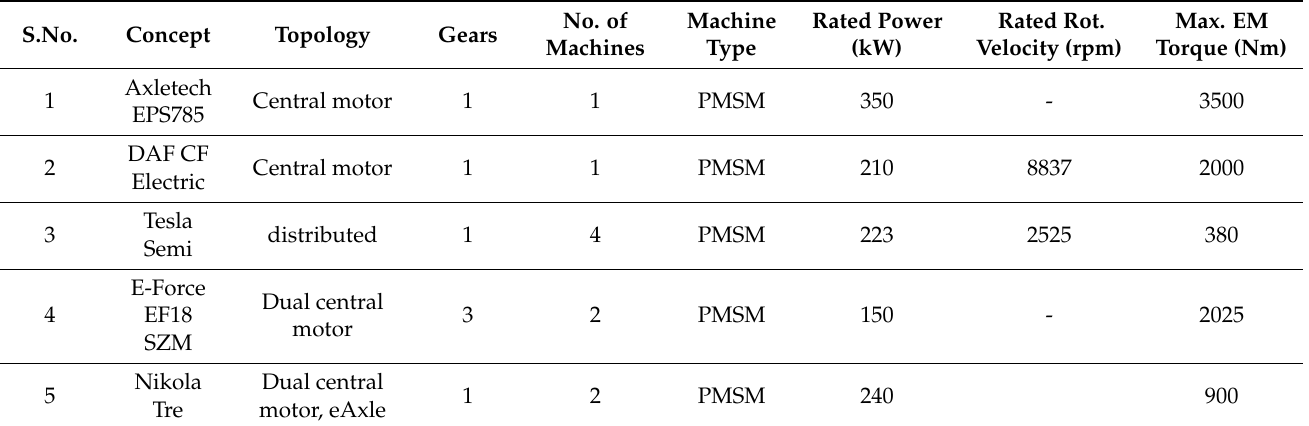
Table 4. Summary of heavy-duty trucks of various OEMs and their corresponding powertrain topology parameters considered [22].